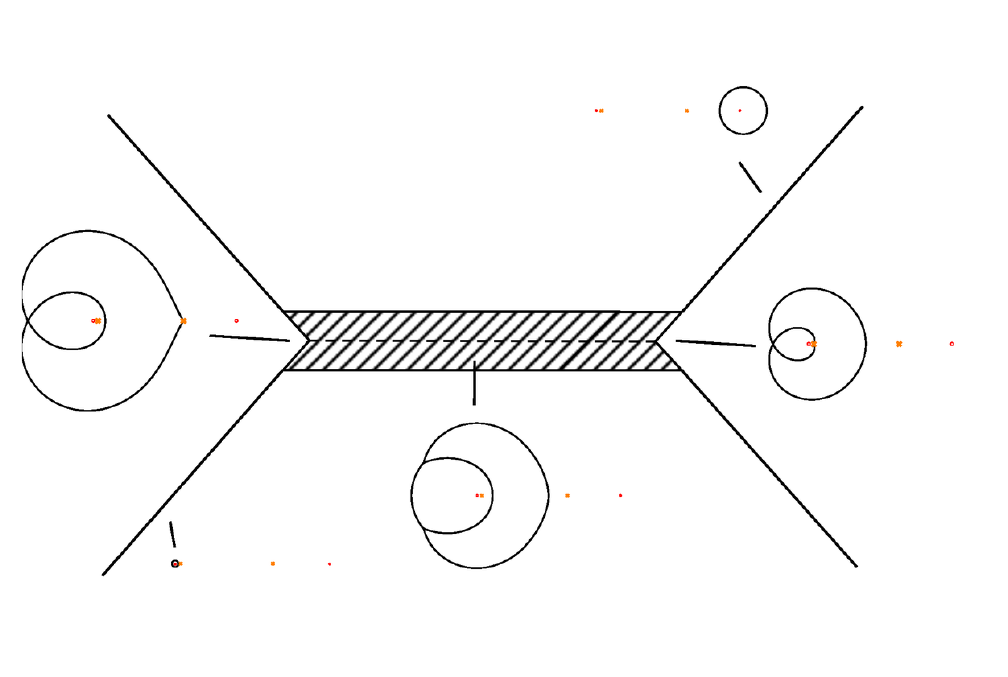
Figure 24. Moduli of D0-brane on the resolved conifold. Networks plotted in a variable such that the x = 1 puncture lies at (cid:12)nite distance.